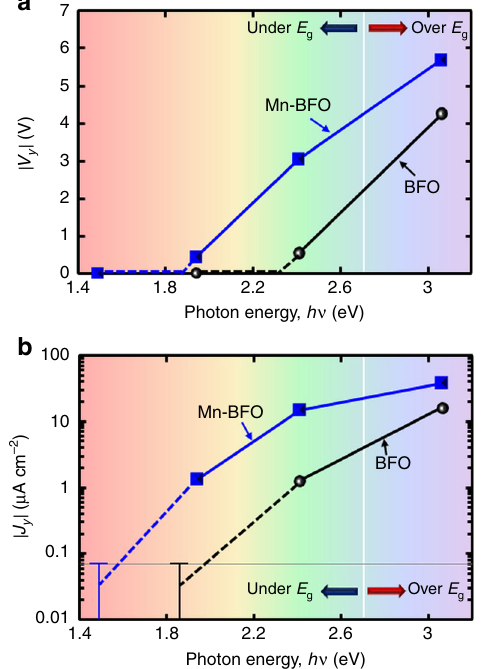
Fig. 4 Photogenerated current and voltage as a function of photon energy ( hv ). a | V y | and b | J y | , where the polarization angle ω is aligned so that the PV response becomes maximum: ω = 90 ° in the BFO fi lm (regardless of hv ); ω = 0 ° at h ν = 3.1 eV, and ω = 90 ° at h ν = 2.4 eV and 1.9 eV in the Mn-BFO (Mn 5 %) fi lm. The horizontal line in b indicates the detection limit in our measurements. The J – V bias properties of the fi lms of BFO ( h ν = 3.1 eV) and Mn-BFO ( h ν = 3.1 eV, 1.9 eV and 1.5 eV) in the y direction are shown in Supplementary Fig. 6a, b 11, respectively